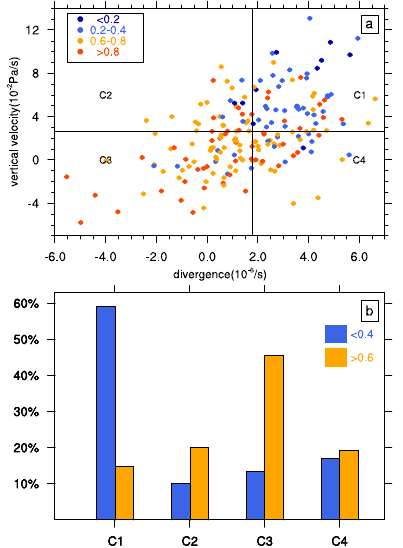
Figure 4. (a) Dependence of AOD on vertical velocity (V: 10 − 2 Pas − 1 ) averaged from 1000 to 100hPa and divergence of wind field (D: 10 − 6 s − 1 ) averaged from 1000 to 850hPa. The vertical black line stands for the climatological mean divergence (1.79 × 10 − 6 s − 1 ) and the horizontal line represents for that of vertical velocity (2.56 × 10 − 2 Pas − 1 ) . The samples are divided into four categories according these the two parameters,